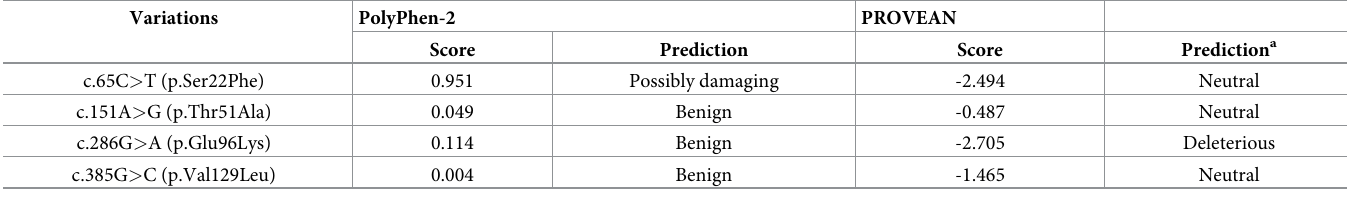
Table 4. Functional prediction of non-synonymous single nucleotide polymorphisms (SNPs) in Korean native black goats by PolyPhen-2 and PROVEAN.